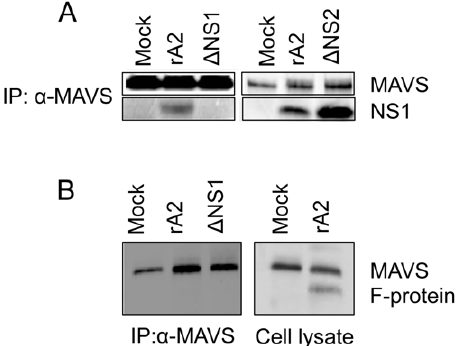
Figure 5. MAVS co-immunoprecipitates with NS1 in epithelial cells infected with rA2- RSV or rA2. ( A ) HEp-2 cells were eithermock-infectedor infected with rA2 or rA2 D NS1or rA2 D NS2 at an MOI of 1. At 24 h p.i., total cell extracts were immunoprecipitated with anti-MAVS followed by western blot analysis using anti-NS1 or anti- MAVS antibodies. ( B ) Whole cell lysates from mock or rA2 infected HEp- 2 cells were immunoblotted for RSV F protein using anti RSV F antibody (Chemicon MAB8262) ( right panel ). The lysates from mock or rA2 or rA2 D NS1 were co-immunoprecipitated with anti-MAVS antibody and probed for MAVS and RSV F protein ( left panel